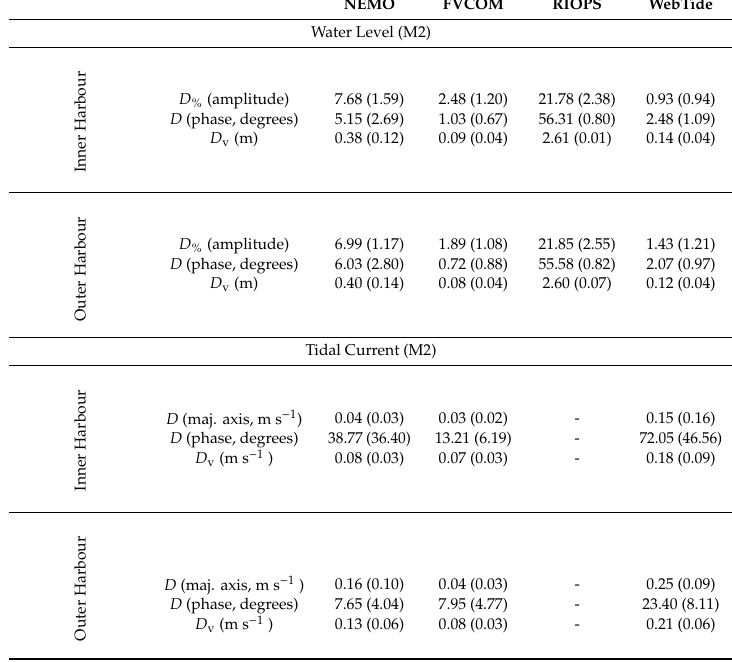
Table 2. The evaluation metrics for the M2 tidal water level and currents (see definitions in equations 1–4 and in the text), averaged for the stations in the inner and outer Saint John Harbour (SJH). Numbers in brackets are the standard deviations across the stations. The metrics are computed for the NEMO, FVCOM, RIOPS and the WebTide solutions, separately. Note that for D and D % , the mean and standard deviations are calculated using the absolute values of the D and D % values at each station.